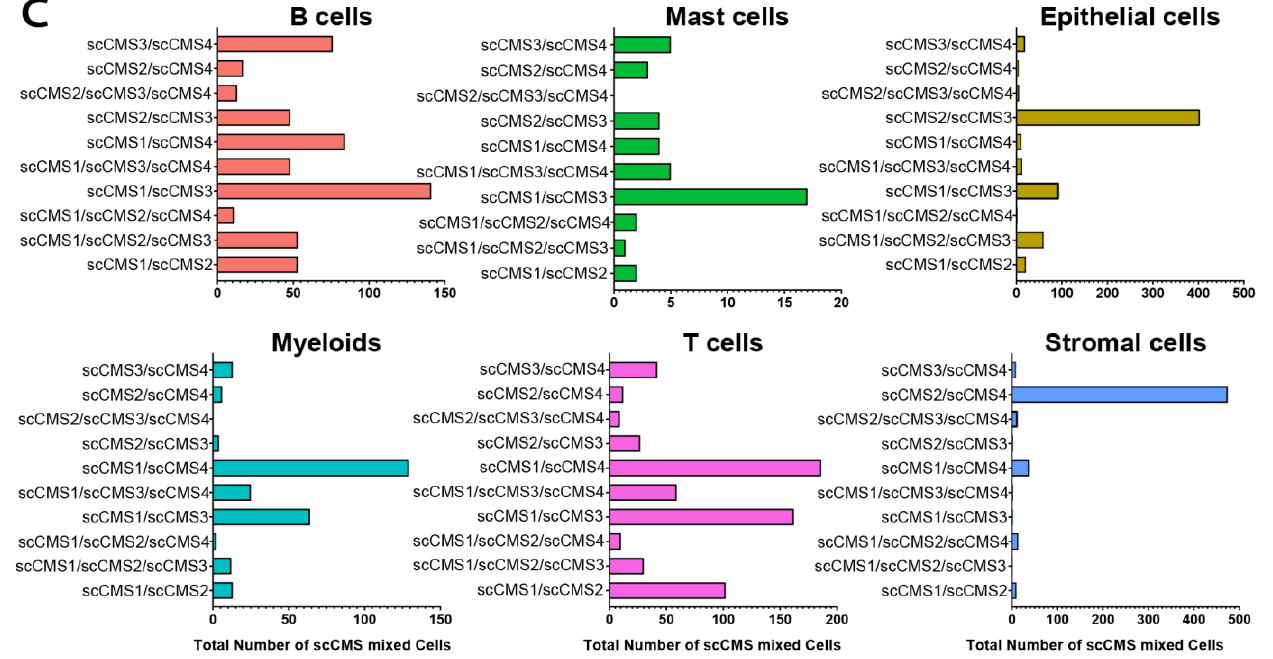
Figure 6. Individual cells with mixed CMS. ( a ) UMAP plot of single tumor cells with mixed transcriptomic states. ( b ) Cell-lineage/cell-type distributions in cells with mixed transcriptomic states. ( c ) Total scCMS-mixed cells within each colorectal-cancer-tissue cell lineage.